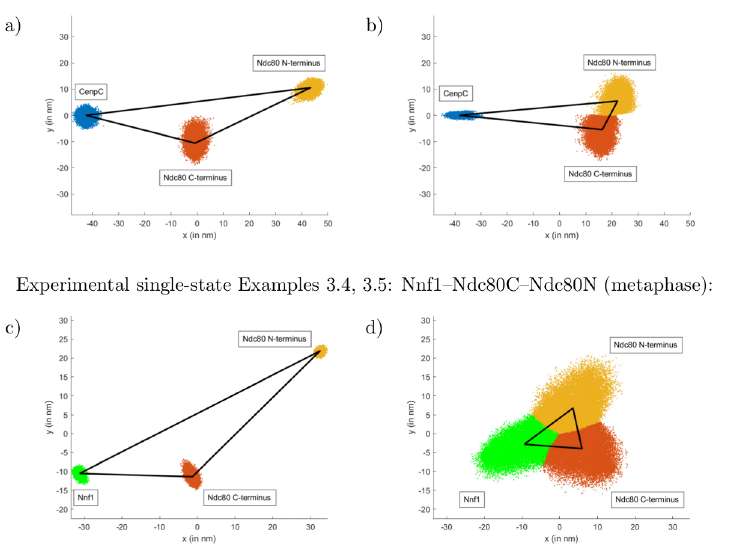
Fig 9. “Average” inferred triangles (Examples 3.2–3.5). The left panels (a,c) are DMSO, the right panels (b,d) nocodazole treated, respectively. The conformational change under nocodazole treatment is clearly visible. The “average” triangles (black lines) are calculated by choosing the perspectives and lengths of the “average” triangle to minimise the Euclidean distance to all triangle templates { X j } j sampled via our MCMC. The point-clouds show the nodes of the triangle template samples for these optimised perspectives (relative to the fixed “average” triangle in the x - y -plane as depicted). The lines connecting these nodes are omitted for better visibility. This is an alternative representation of panels c) in Figs 6–8, M in S1